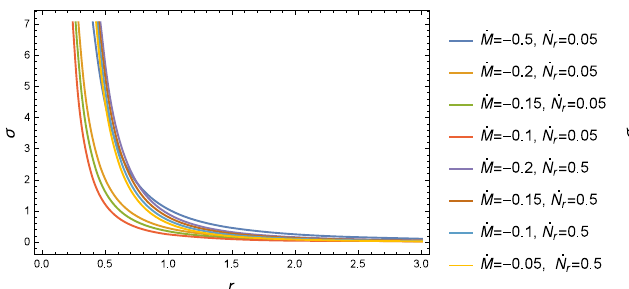
Fig. 6 Leftfigure:theradiation-accretiondensity σ versusthedistance r for some typical constant ˙ M and ˙ N r values for (cid:5) = − 1 in the radi- ation background. Here, σ( r ) is a decreasing function but is positive, and consequently the positive energy condition is satisfied everywhere in spacetime. Right figure: the radiation-accretion density σ versus the